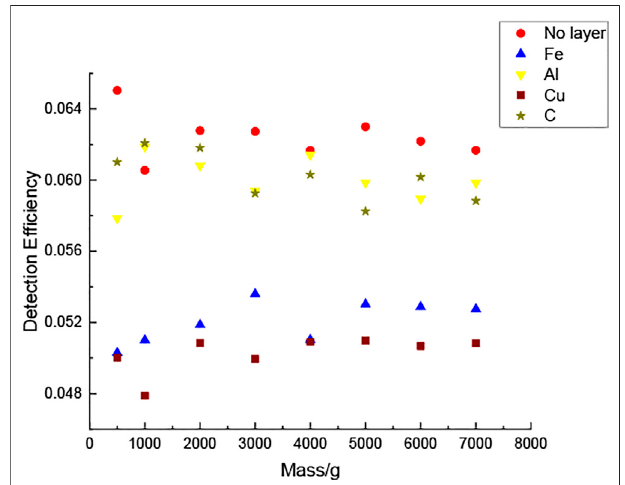
FIGURE 7 | Fitting result of the coincidence counting rate.